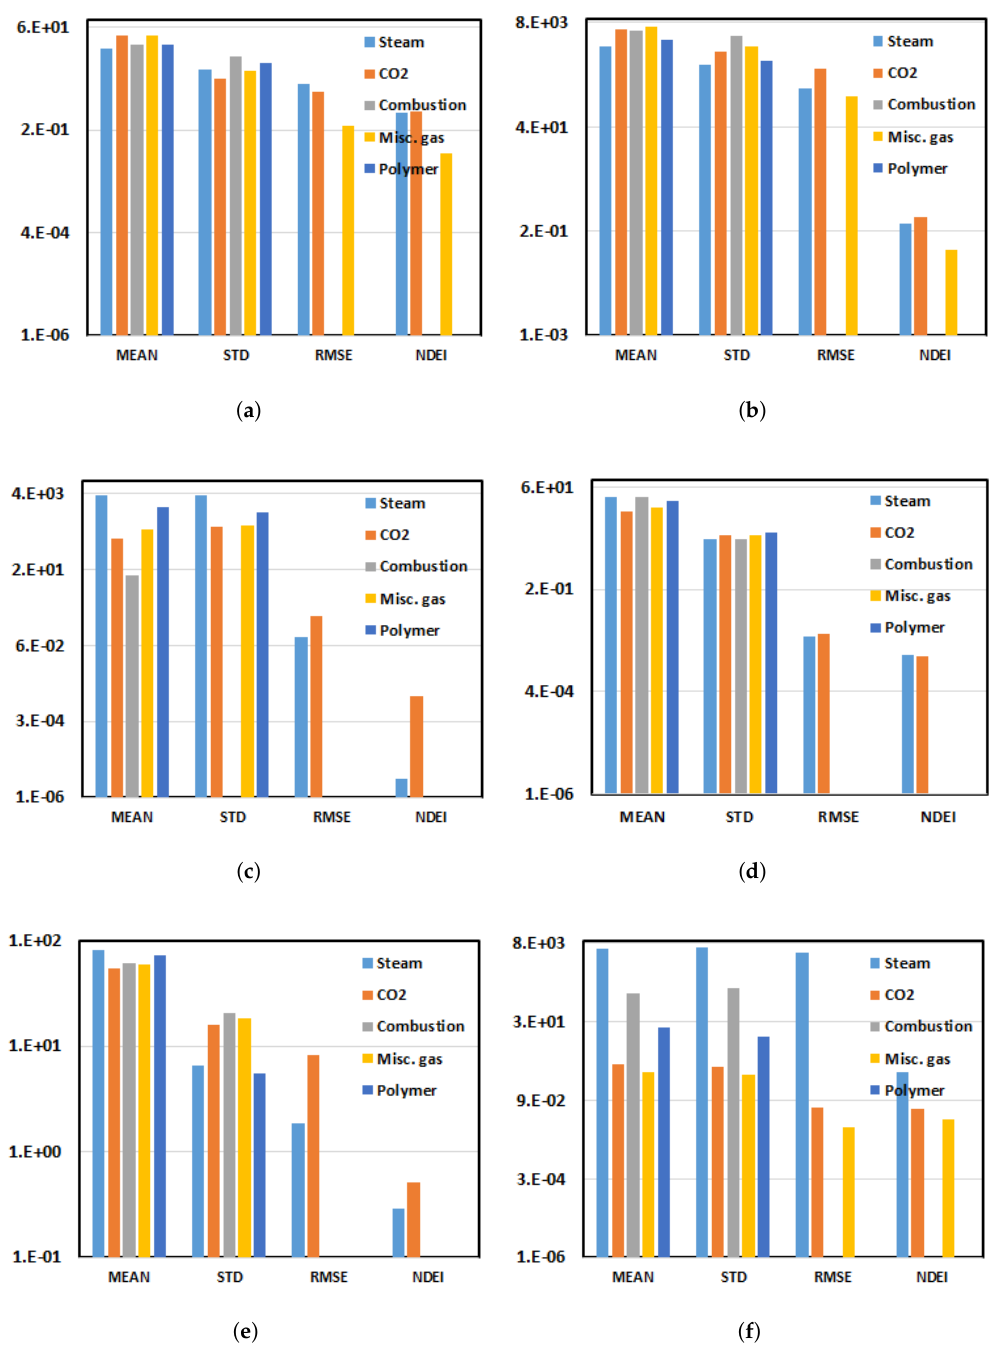
Figure A7. Statistical data plots of steam, CO 2 , combustion, miscible gas and polymer injection for Area 2 of the Angolan oilfield (See Table 4 for the area clarification). Variables include: ( a ) API; ( b ) depth; ( c ) permeability; ( d ) porosity; ( e ) saturation; and ( f )